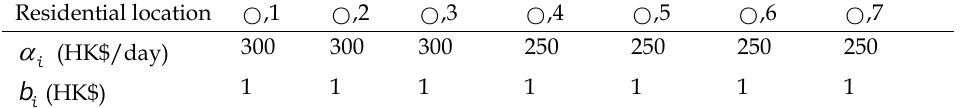
Table 4. Parameters for housing rent function of the above corridor network Residential